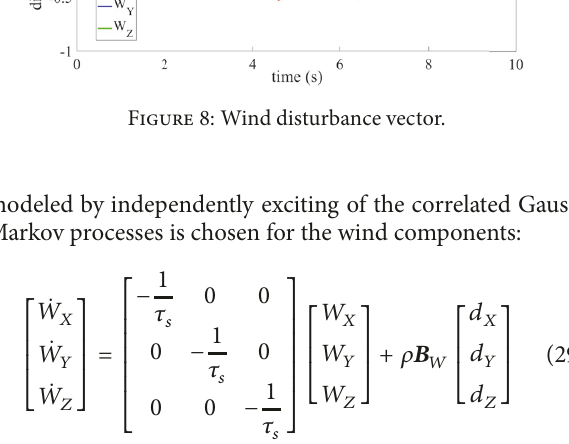
Figure 7: LQG controller.